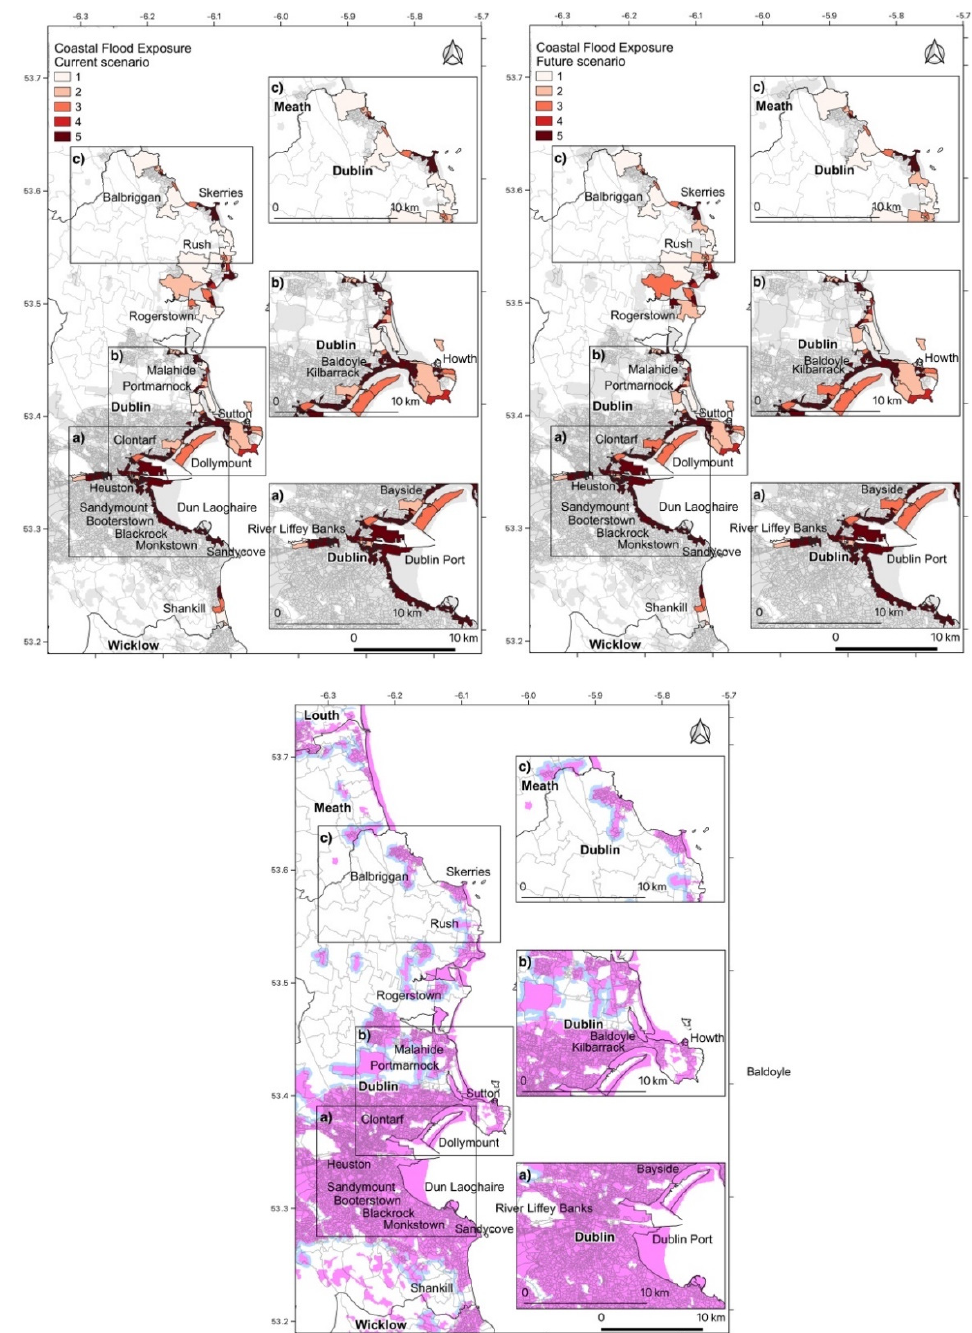
Figure 5. Coastal Flood Exposure index (E) across County Dublin for the current period ( upper left panel ) and future period ( upper right panel ). The index ranges from 1 (very low exposure) to 5 (very high exposure). The lower panel shows the increase in urban areas between the two periods, i.e., the current (pink) and future scenario (light blue). Panels information as in Figure 3.